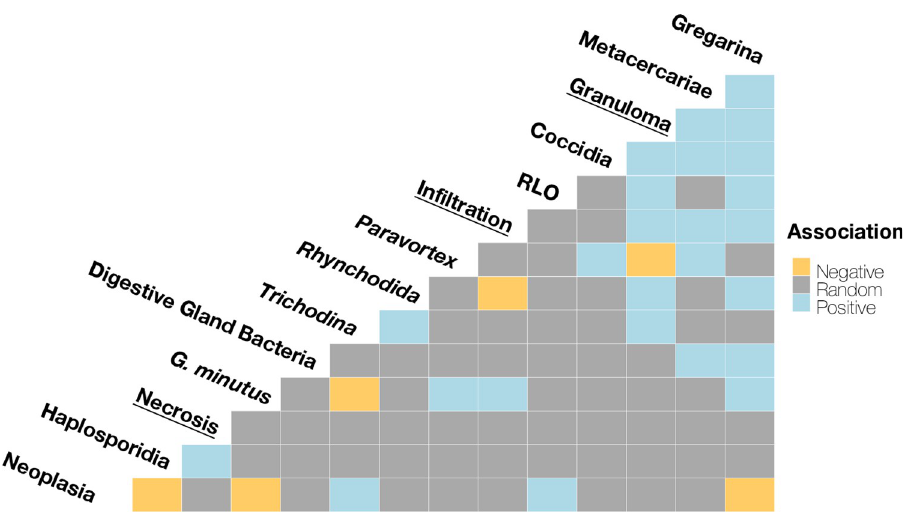
Fig 3. Heat map demonstrating a species co-occurrence matrix, showing relationships between parasite species and cockle pathologies (underlined) as determined by a probabilistic co-occurrence model from the “cooccur” package in R. Species names indicate the pairwise comparisons